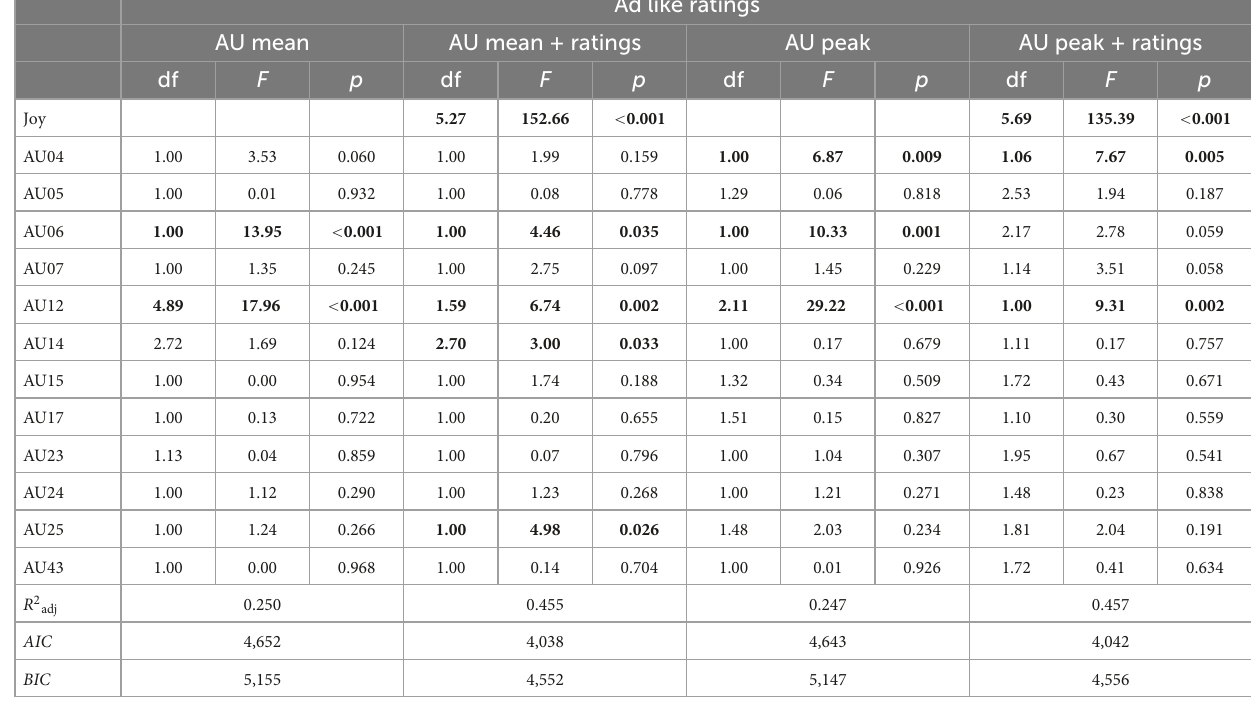
TABLE 4 Prediction of advertisement likeability ratings based on mean and peak Action Unit (AU) activity with and without self-report ratings. Ad like ratings